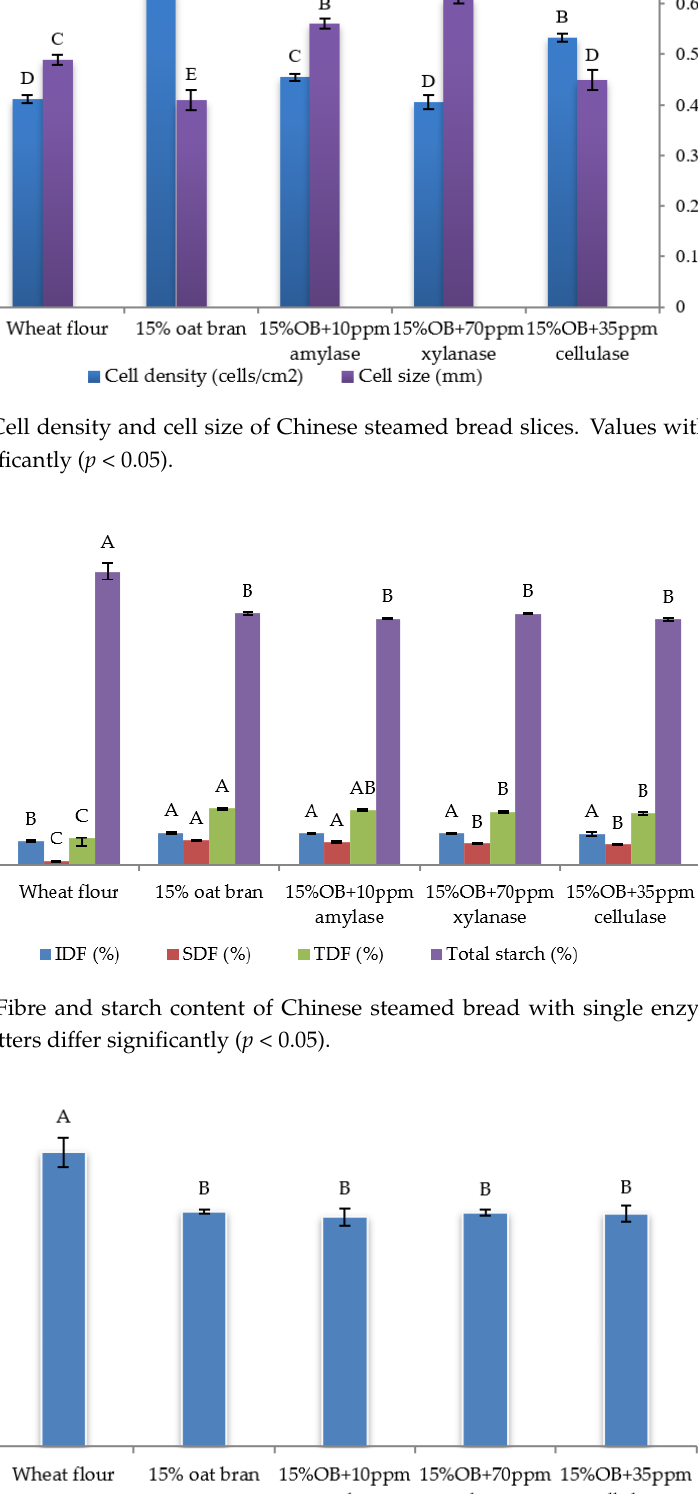
Figure 5. The area under curve value of Chinese steamed bread with single enzyme for predictive glycaemic response. Values with different letters differ significantly ( p <